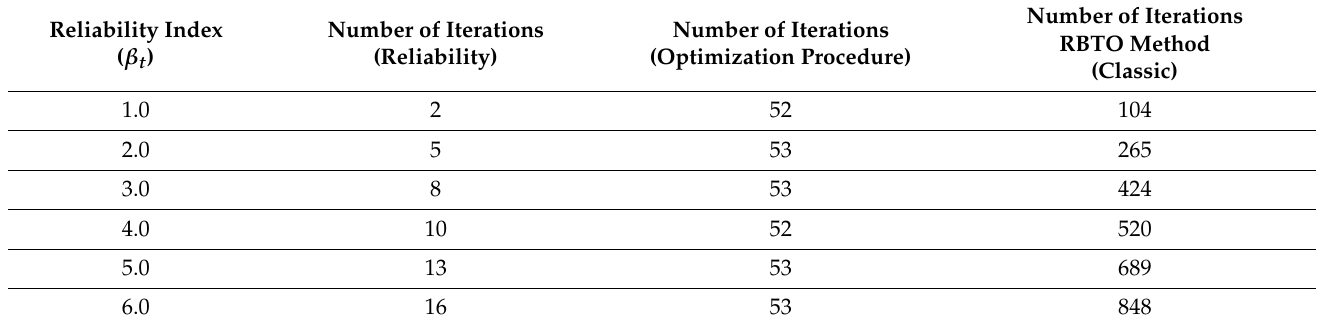
Table 5. Efficiency of the proposed approach for different reliability